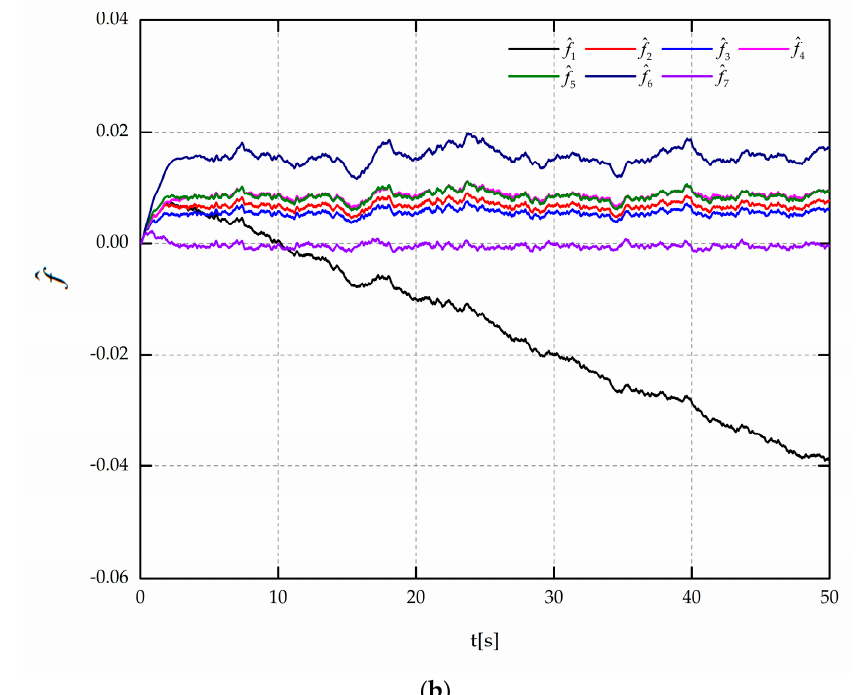
Figure 11. Sensor fault reconstruction in Mode 2: ( a ) Robust sensor fault reconstruction ˆ f ( b ) ˆ f reconstruction without robust design.